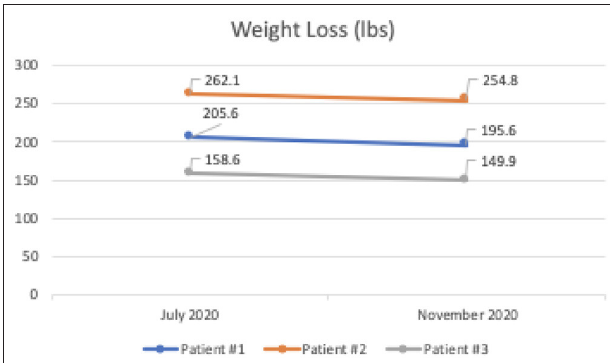
FIGURE 2 | Weight loss (lbs) of all three patients during the